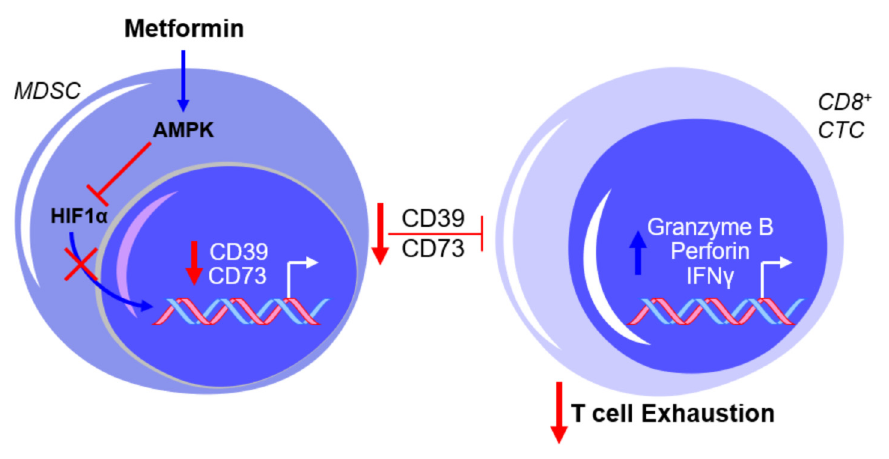
Figure 2. Metformin prevents myeloid-derived suppressor cell (MDSC)-mediated T cell exhaustion by downregulating CD39 and CD73 expression. The exposure of MDSCs to metformin activates AMPK and inhibits hypoxia-inducible factor 1-alpha (HIF1 α ) expression, thereby inhibiting the HIF1 α -mediated transcriptional upregulation of CD39 and CD73 and subsequently suppressing cytotoxic CD8 + T lymphocytes (CTCs). This results in a net effect of reduced T cell exhaustion. Blue arrows indicate upregulation/activation, red arrows indicate downregulation/inactivation and red T symbols indicate